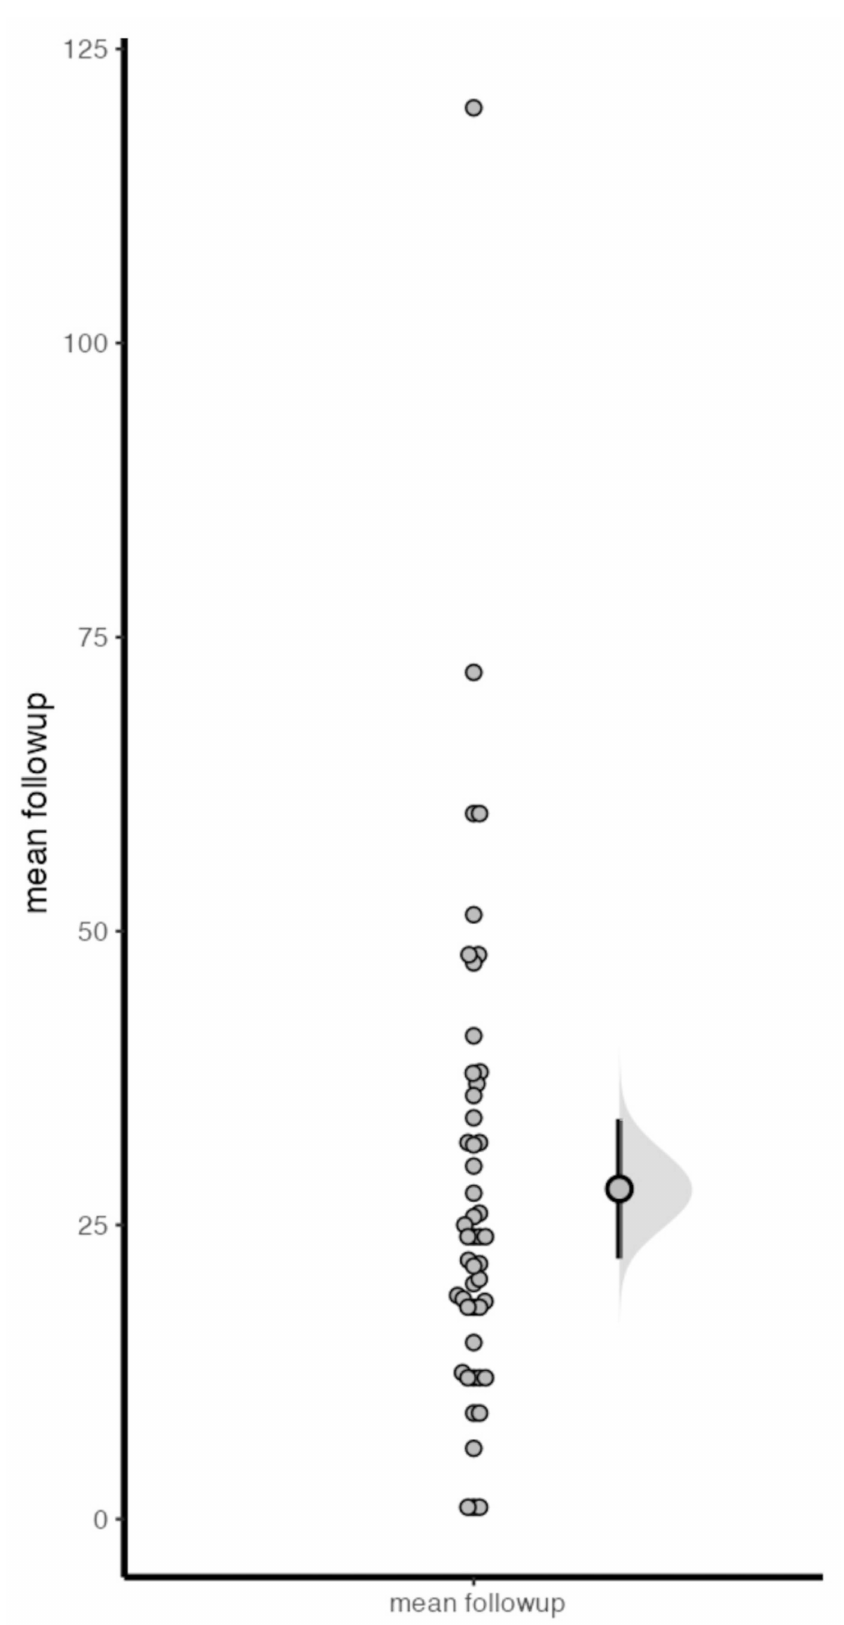
Figure 2. Pool of all follow-up duration data for all studies considered in the present